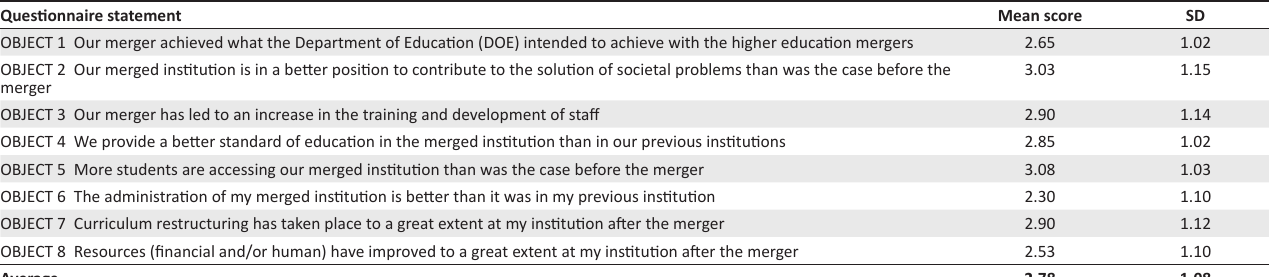
TABLE 5: Merger goal success: Descriptive